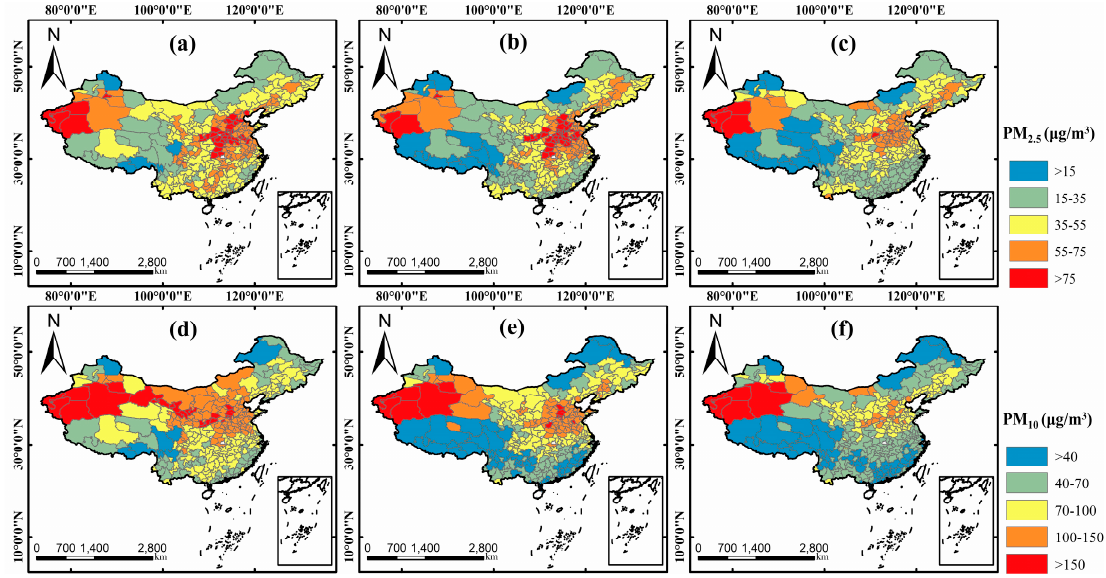
Figure 2. PM concentrations in Chinese prefectural cities of the study period in 2018 (( a ) for PM 2.5 and ( d ) for PM 10 ); 2019 (( b ) for PM 2.5 and ( e ) for PM 10 ); and 2020 (( c ) for PM 2.5 and ( f ) for PM 10 ). Table 2. Average PM concentration comparison between background sites (BS) and non-background sites (NS).